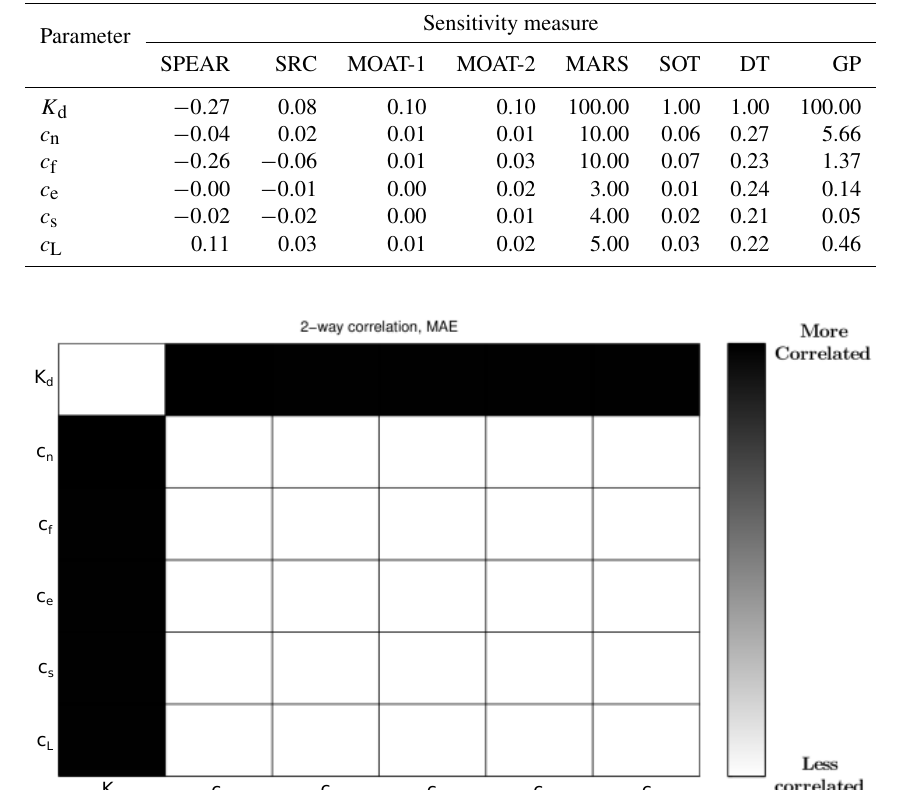
Figure 4. Two-way correlation between selected parameters of the Canadian Small Lake Model. This indicates how much the value of a given parameter is dependent on the value of another one to produce good simulations. The mean absolute error was used to evaluate the model. McKay-2 (McKay et al., 1999) was used to evaluate the